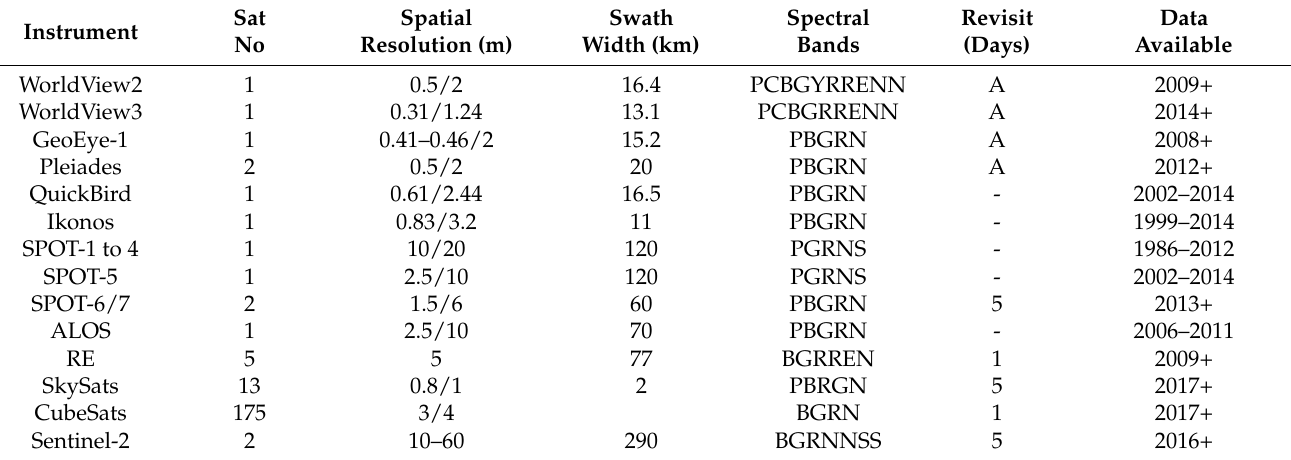
Table A1. Key satellite optical imager specifications for comparison.